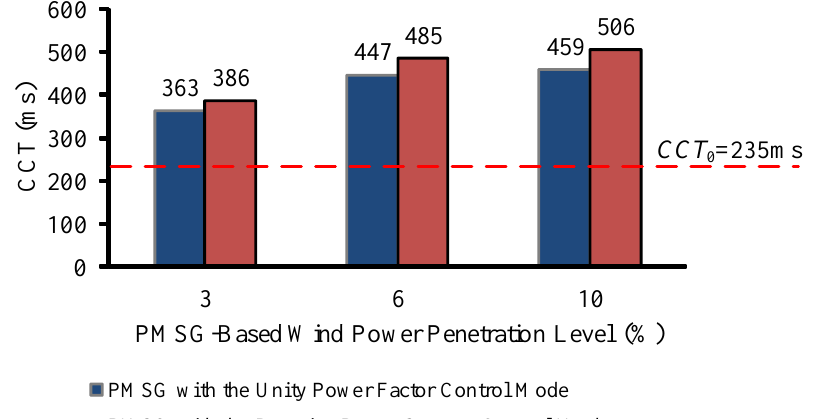
Figure 17. CCTs of the fault on line 10–13 in the scenarios of PMSG-based wind power balanced by G3.